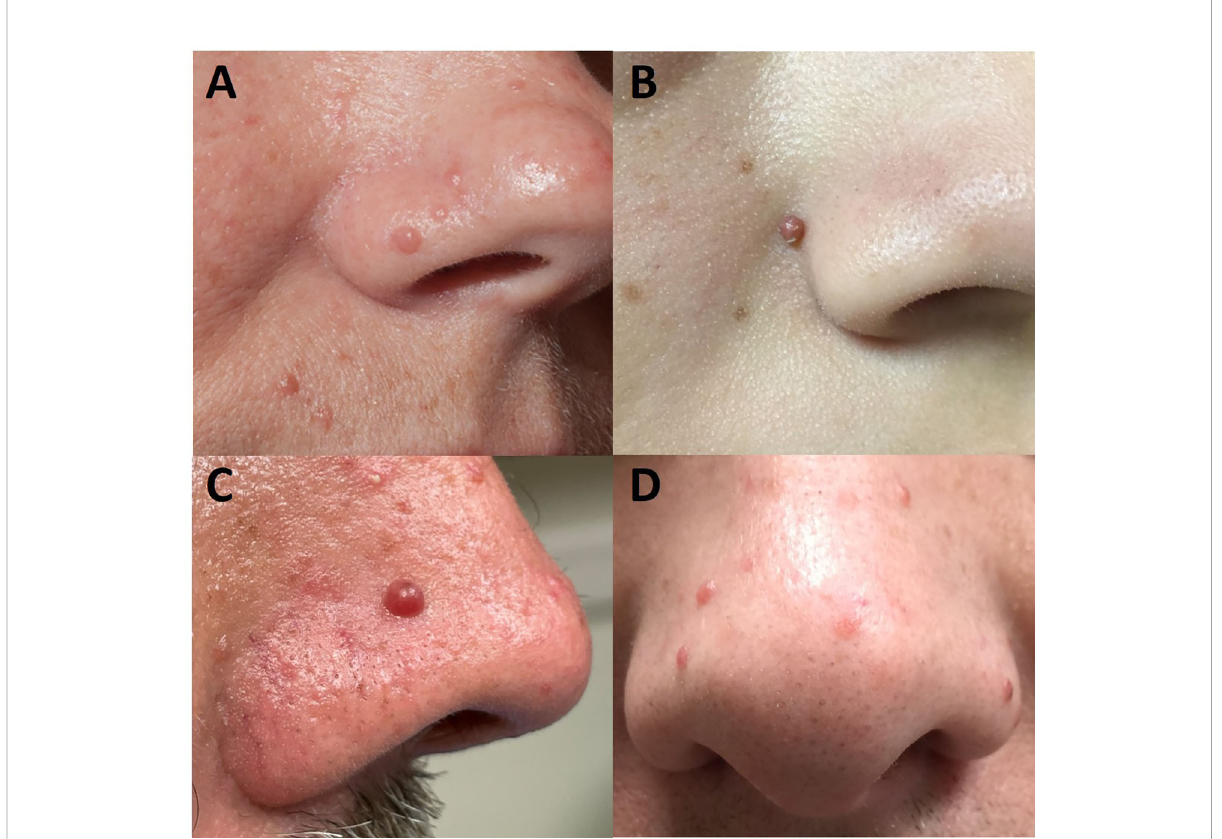
Angio fi broma Angio fi bromas (Figure 1) are benign fi broblastic tumors that histologically comprise bland spindle cells in a variably myxoid to collagenous stroma with a prominent vascular network. They present as telangiectatic, skin colored to pink to red-brown, dome-shaped papules with a glistening surface that primarily occur in the central part of the face, especially the nose. They may be mistaken for acne but do not spontaneously